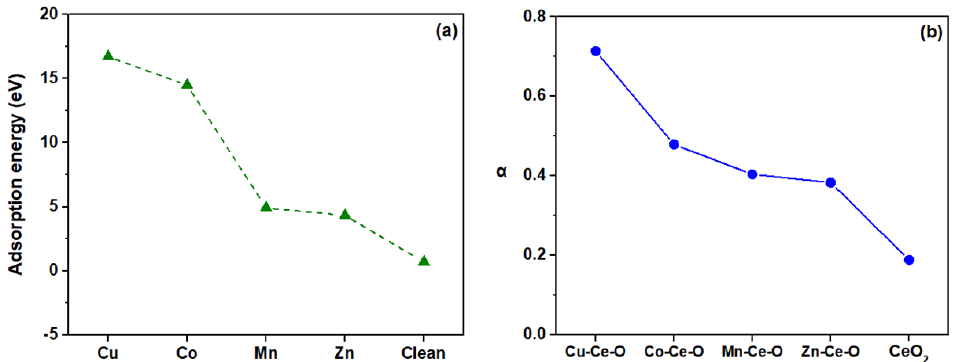
Figure 18. ( a ) Adsorption energy of CO as a function of TM (the clean surface of undoped ceria is also given), ( b ) Ratio (α) of the amount of C 16 O (mmol g −1 ) consumed to the 18 O (μmol g −1 ) exchanged after 20 min in CO oxidation on the same doped-ceria catalysts. Adapted from Ref. [169]. Copyright© 2021, American Chemical Society. Notice to readers: Further permissions related to the material excerpt should be directed to the ACS.